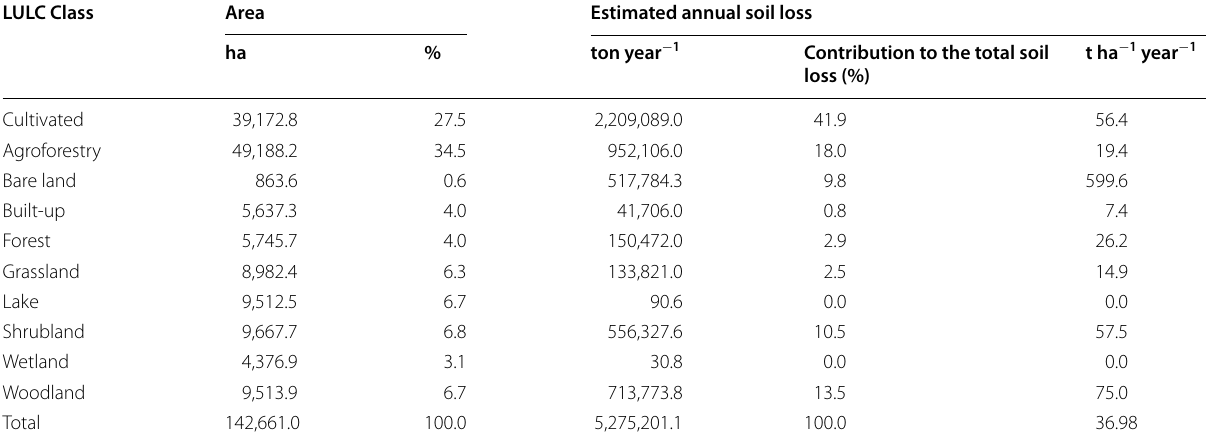
Table 6 Variation of annual soil erosion rates with LULC types LULC Class